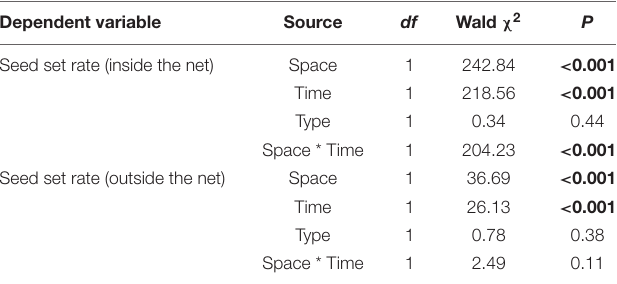
TABLE 2 | Generalized linear mixed (GLM) model analysis of the effects of space (central vs. peripheral sites), time (early vs. late florescence) and morph (L- vs. S-morph) on seed set rate of Primula wannanensis plants covered with or without a net in natural